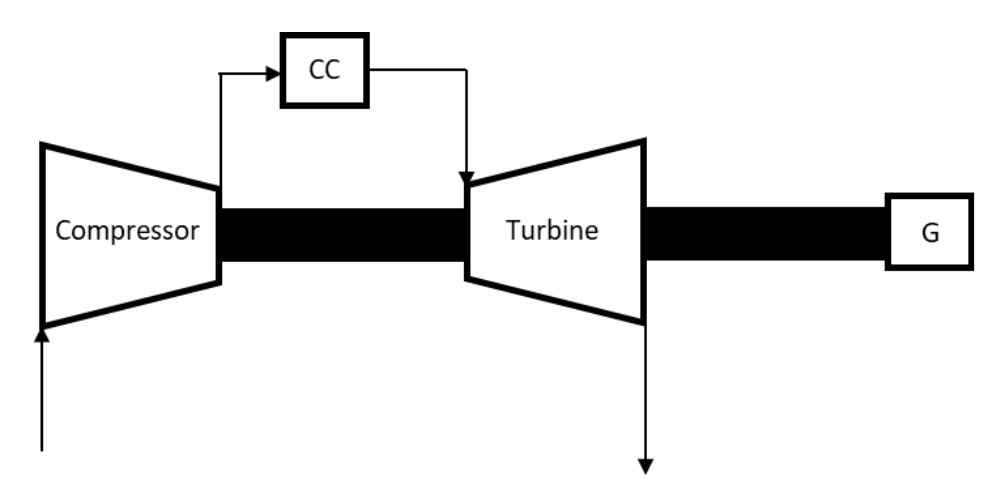
Figure 2. Single shaft GT cycle.